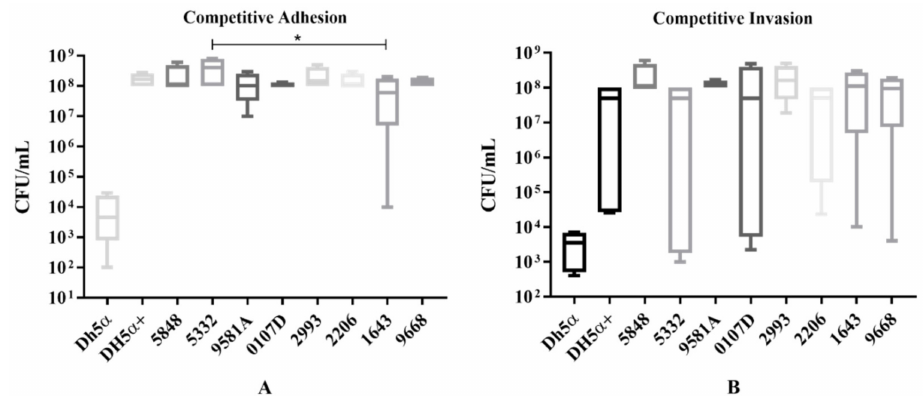
Figure 5. Competitive adhesion and invasion assay. ( A ) Adhesion to HEK-293 (human embryonic kidney cell line) calculated in CFU / mL. ( B ) Invasion of HEK-293 for the same isolates. In both assays, results obtained from the plasmid containing isolates 5332 and 5848 were compared with other ST131 clinical isolates (9581A, 2206, 0107D), with ST648 (2993), ST354 (1643), ST297 (9668) and ST69 (7719) isolates, and with both the parental DH5 α and the transformant DH5 α + strains. The * indicates a statistically significant di ff erence ( p ≤